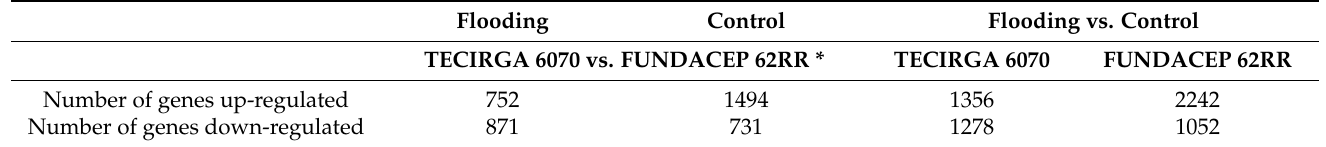
Table 2. Differential expression statistics.